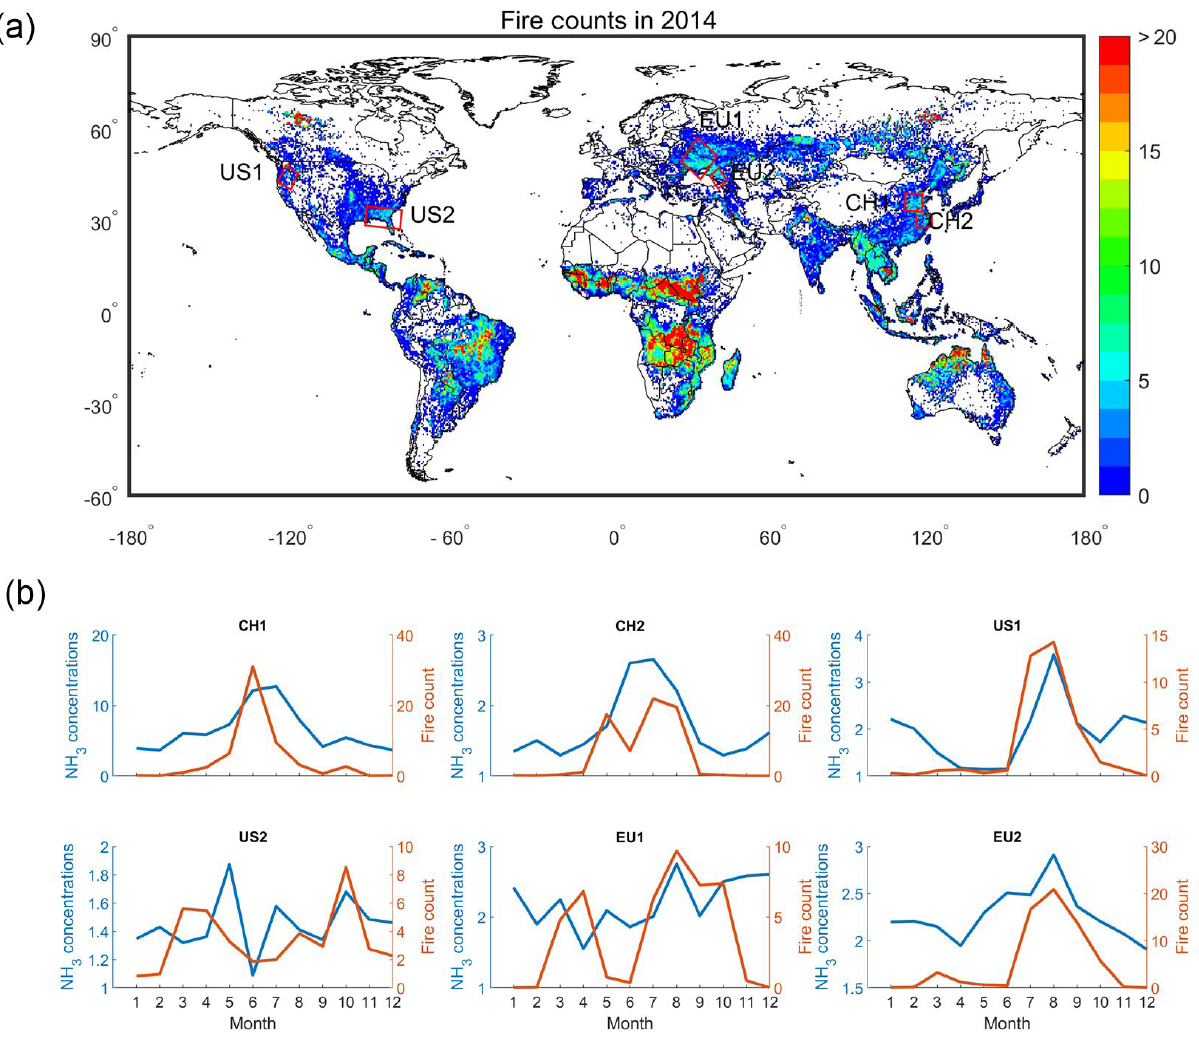
Figure 8. MODIS fire counts in 2014. (a) Spatial distributions of MODIS fire counts. (b) Monthly variations in fire counts and surface NH 3 concentrations in biomass burning regions in China, the US and